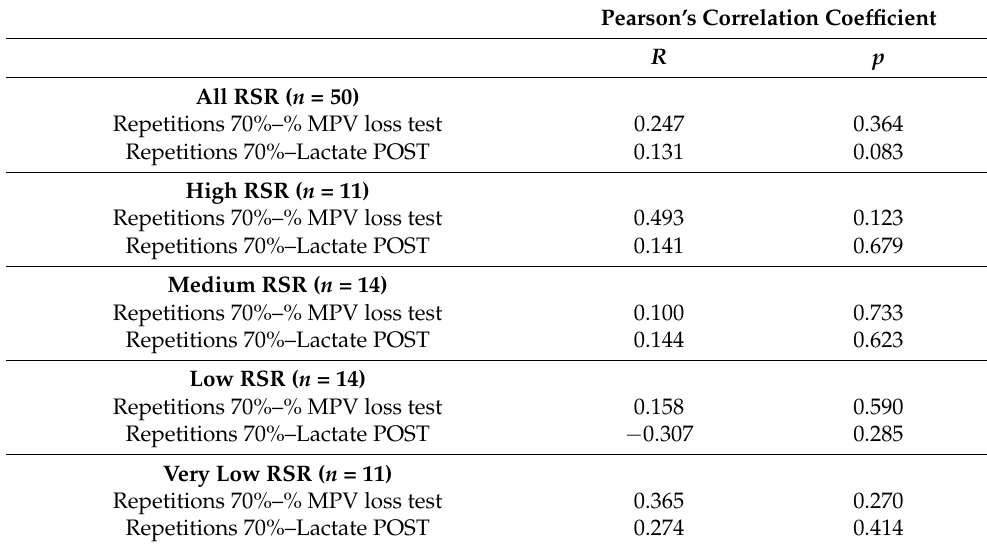
Table 4. Regression and correlation analysis for the four strength groupings.